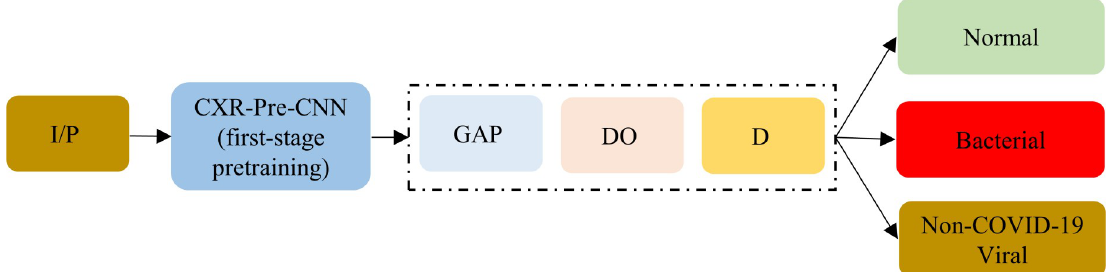
Fig 6. The architecture of the CNNs used in the second stage of pretraining. I/P = Input, CXR-Pre-CNN = CXR-specific CNNs from the first stage of pretraining, truncated at their deepest convolutional layer, GAP = Global Average Pooling, DO = Dropout, D = Final dense layer with Softmax activation.